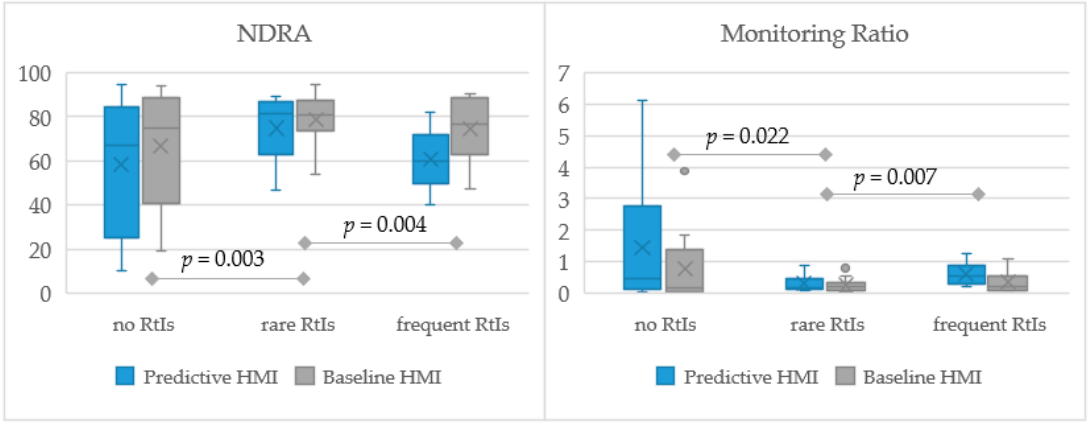
Figure 10. Attention ratio for NDRA and monitoring ratio per drive in the HMI condition (in percent).